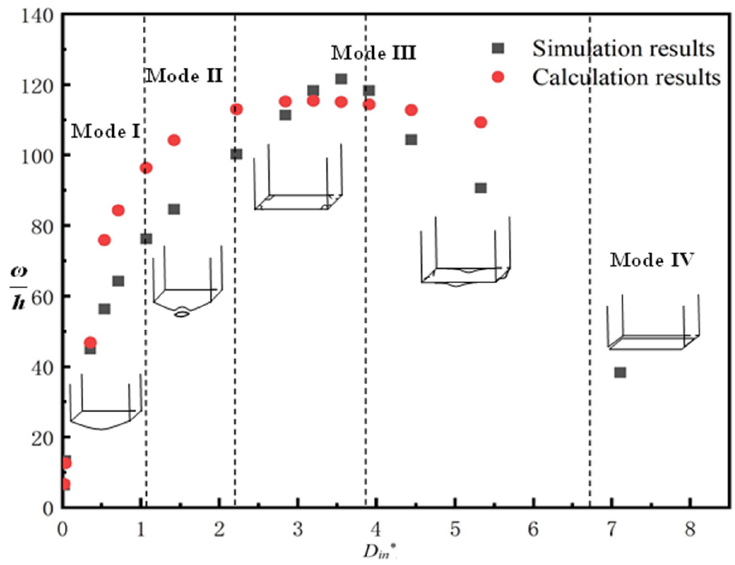
Figure 10. The variation of deflection and damage modes of box structures with 𝐷 (cid:3036)(cid:3041)∗ .